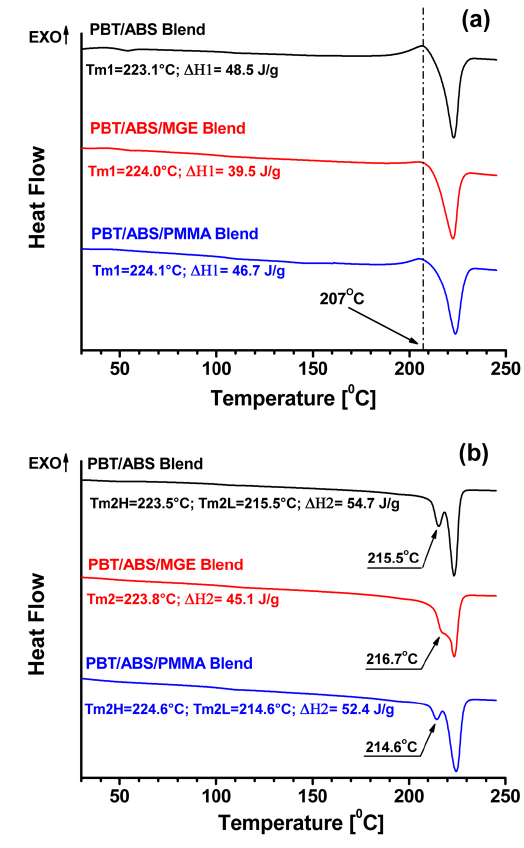
Figure 3. DSC thermograms of the PBT/ABS blends after extrusion, where: (a) 1st heating thermograms, (b) Second heating